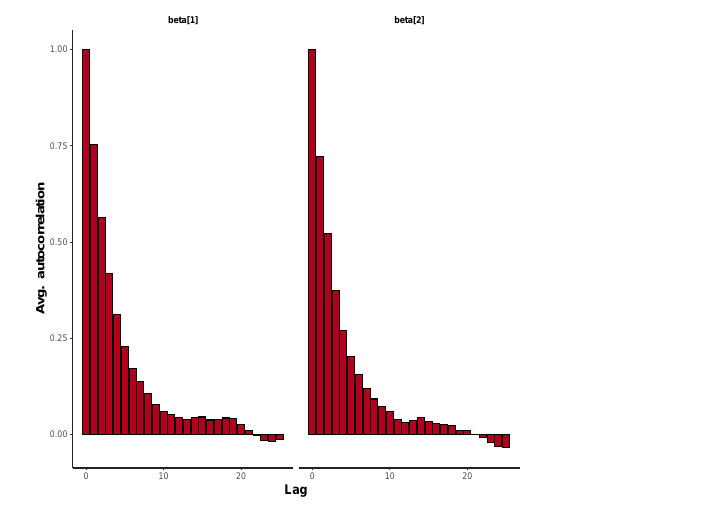
Figure 7 – The plots of the autocorrelation of the MO-G model.